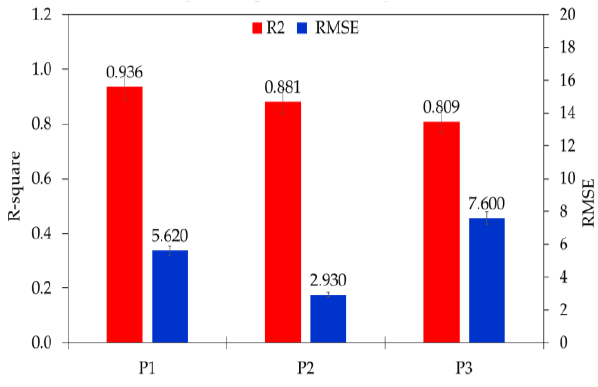
Figure 10. Single-well prediction using Bi-LSTM.